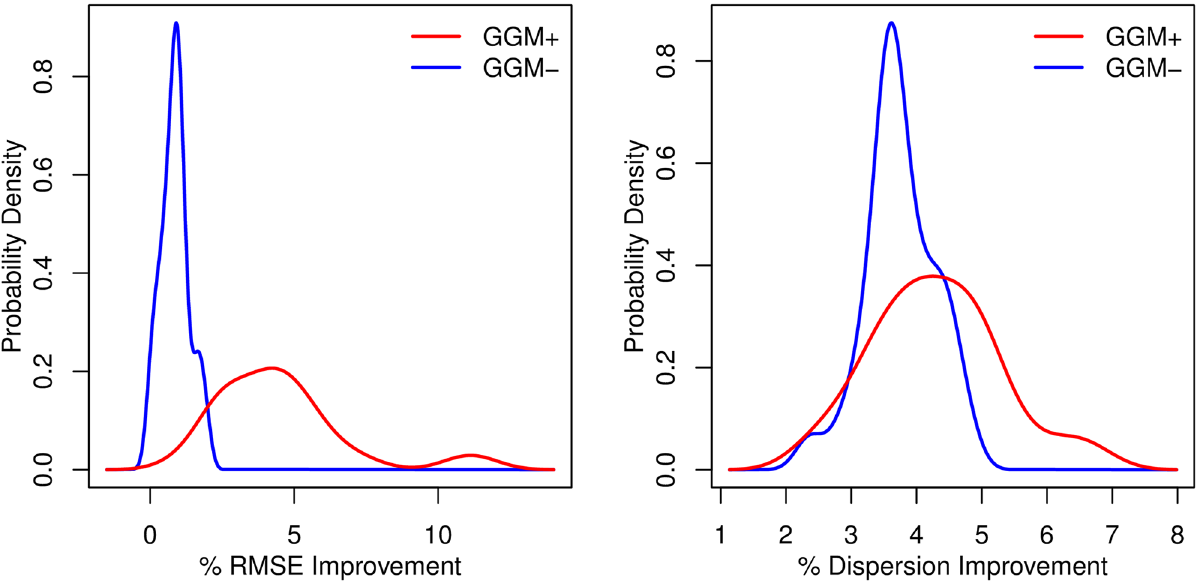
Fig 3. Distribution of % improvement in GELnets over elastic nets for RMSE and dispersion performance metrics. Red curve corresponds to the case where GELnets were provided with the true network used to generate the data. Blue curve depicts the case where the permuted network was provided instead.